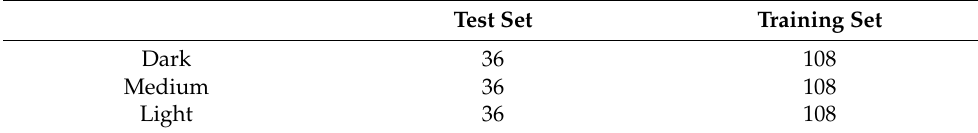
Table 7. Distribution of the expanded